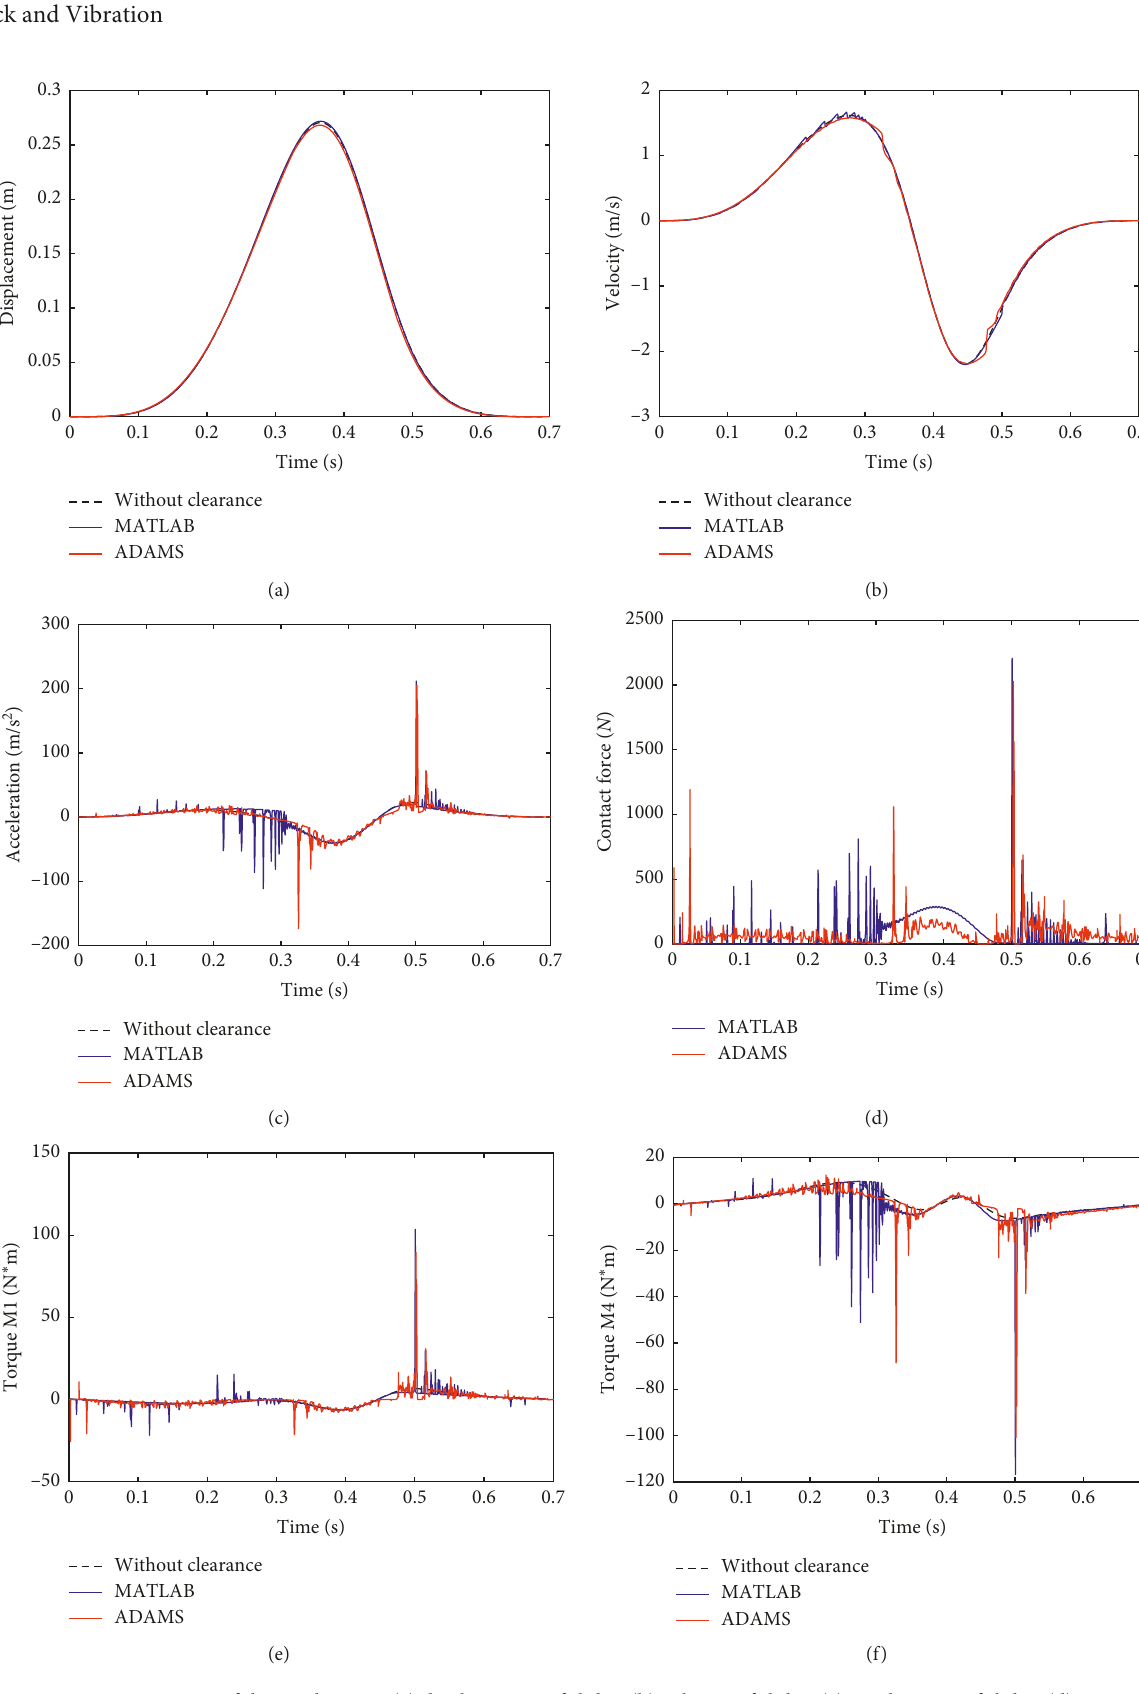
Figure 5: Dynamic response of the mechanism: (a) displacement of slider; (b) velocity of slider; (c) acceleration of slider; (d) contact force; (e) driving torque of crank 1; (f) driving torque of crank